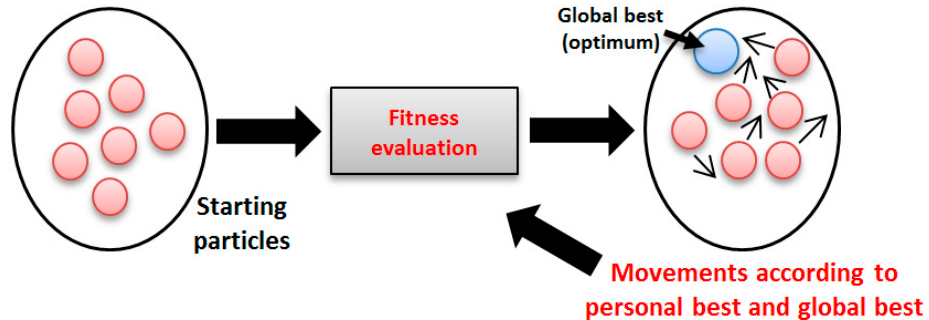
Figure 2. Typical algorithmic flow in the particle swarm optimization technique.